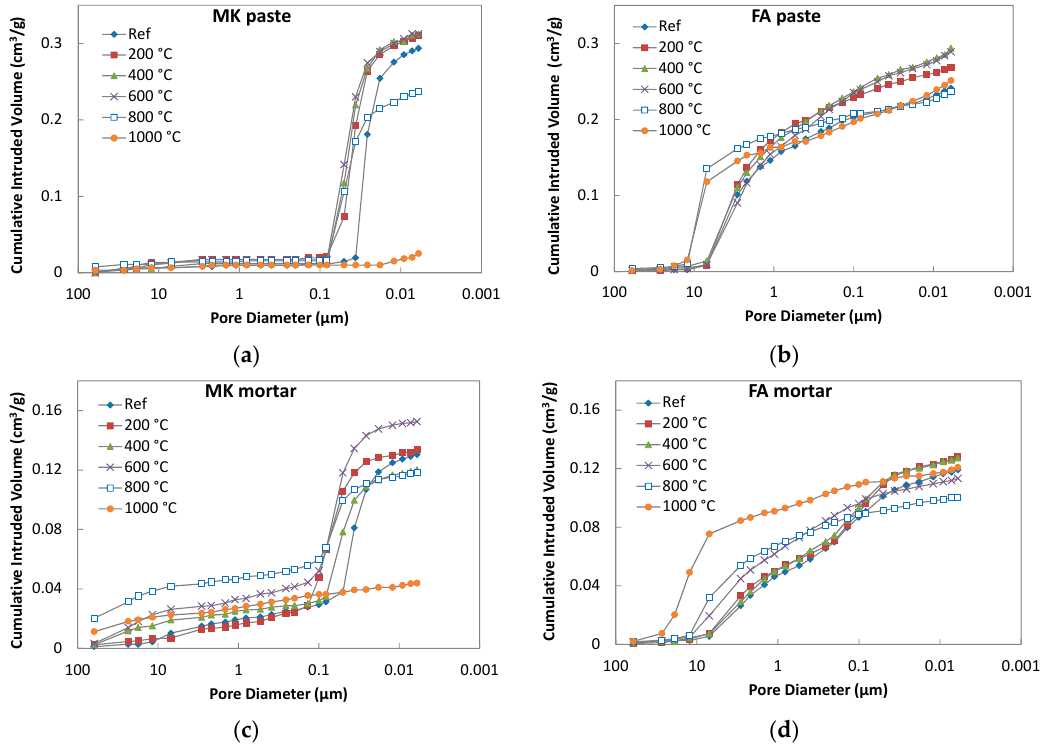
Figure 9. Cumulative intruded volume of geopolymer pastes and mortars subjected to temperatures of 200–1000 °C. ( a ) MK paste; ( b ) FA paste; ( c ) MK mortar; ( d ) FA mortar.